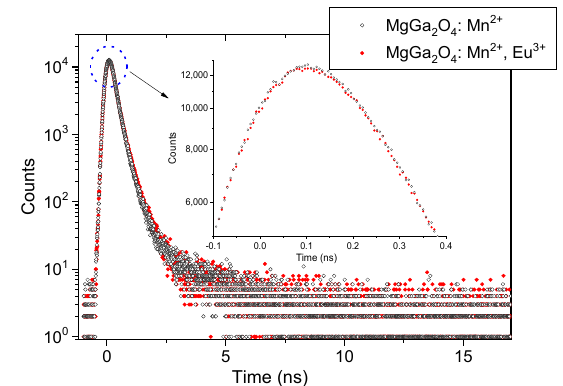
Fig. 5 Comparison of raw PAL spectra of spinel- structured MgGa 2 O 4 :Mn 2+ and Eu-doped MgGa 2 O 4 :Mn 2+ ceramics (the insert shows magnified peak region). Table 3 PAL spectra fitting parameters for studied spinel-structured ceramics within unconstrained x3-term decomposition Fitting parameter Ceramics